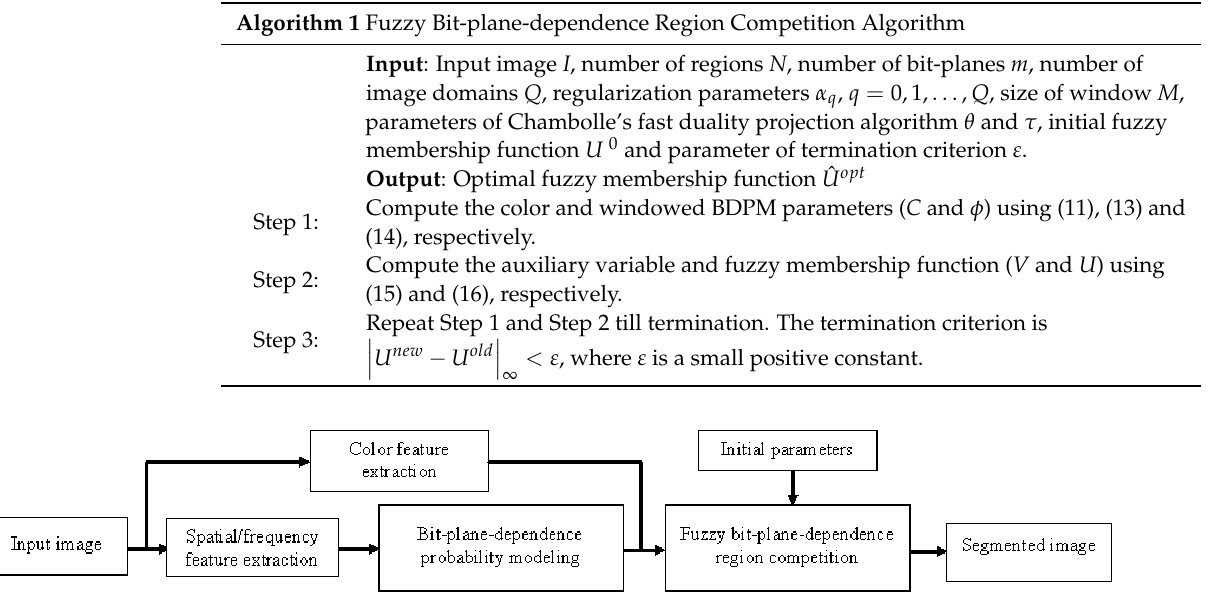
Figure 1. The overall implementation of the proposed method. Algorithm 1 Fuzzy Bit-plane-dependence Region Competition Algorithm